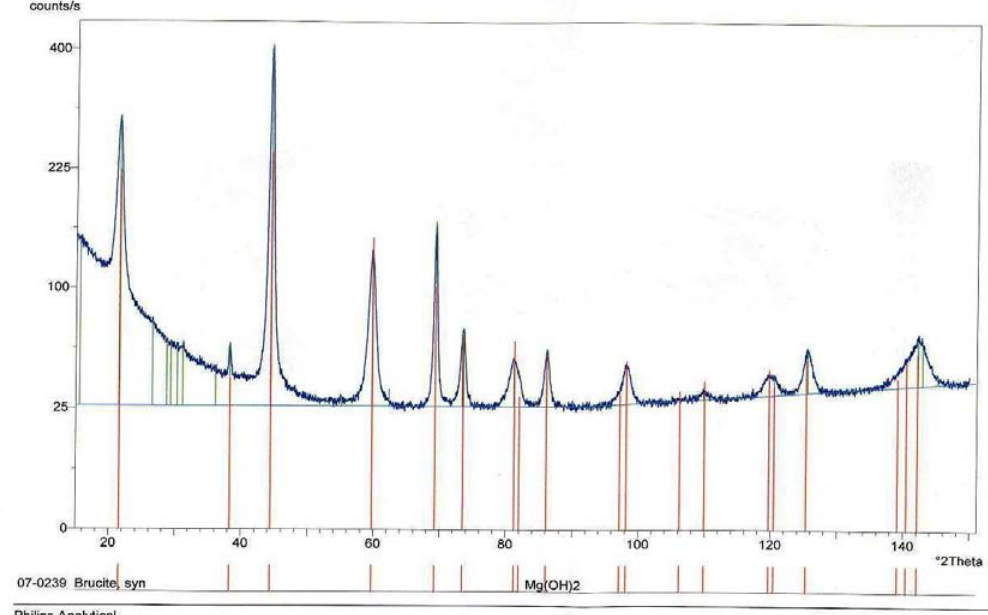
Figure 2. The XRD spectrum of nano Mg(OH) 2 prepared in this work and confirming the brucite crystal structure of the precipitated nMg(OH) 2 particles.